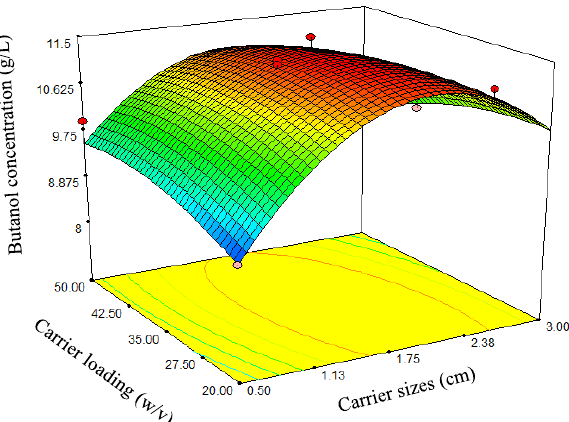
Figure 10. Three-dimensional response surface plots for butanol production — effects of the carrier